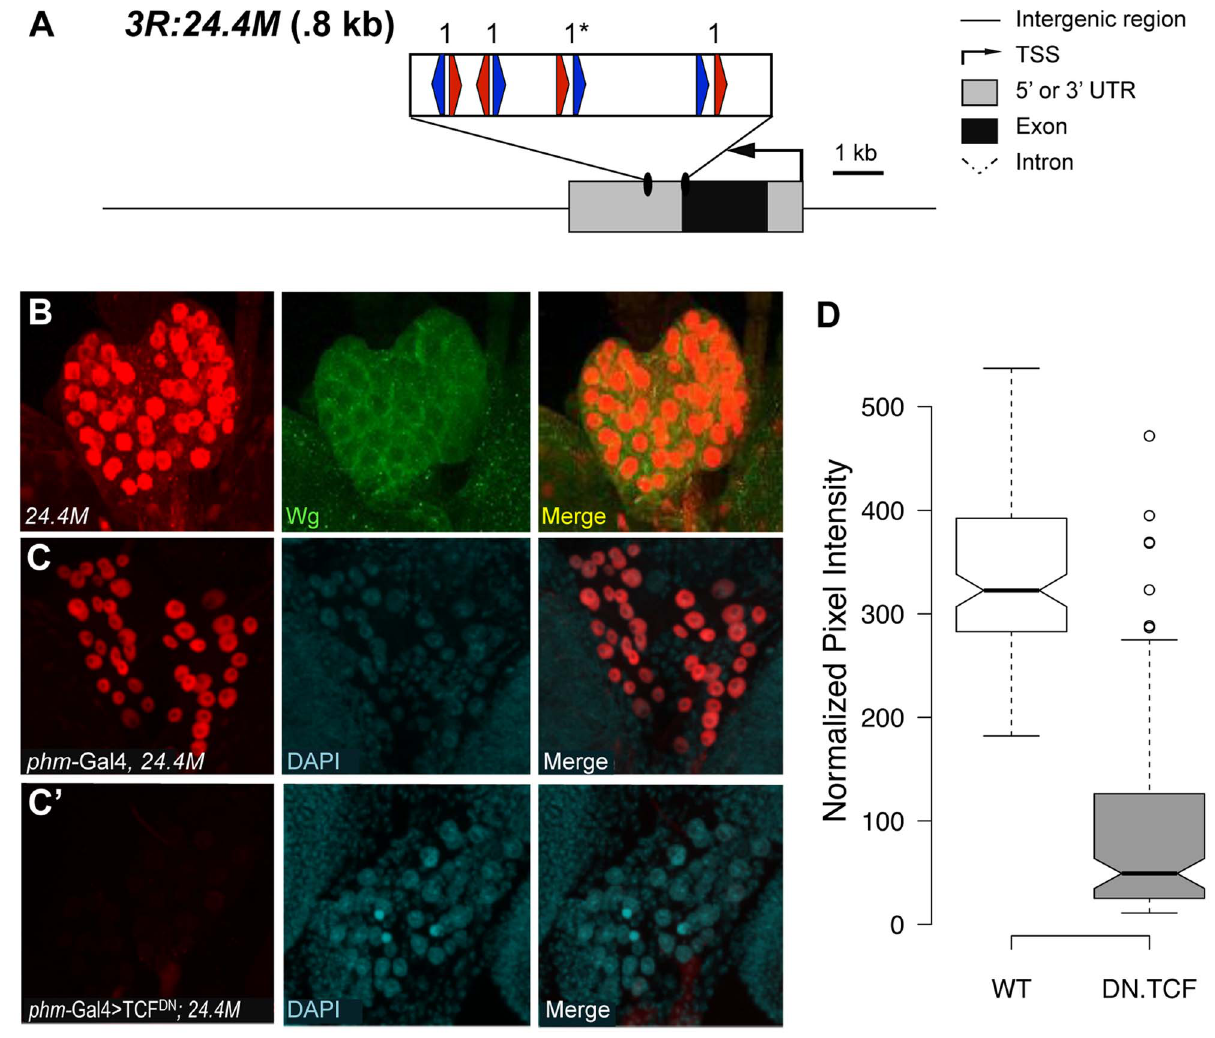
Figure 9. Identification of a W-CRM at 3R:24.4M that is active in the ring gland. (A) Cartoon of the W-CRM in relation to the fkh gene, with the location of HMG (red arrows) and Helper (blue arrows) sites indicated, along with their spacing. Asterisks indicate the high scoring FF1 motif identified in the initial computational search. (B) Confocal images of a 3 rd instar larval ring gland from a 3R:24.4M fly immunostained for lacZ and Wg. The large lateral cells of the prothoracic gland (PG) display strong nuclear LacZ staining. Wg protein can be seen at the cortical surface of these cells. (C, C 9 ) Confocal images of ring glands from phm Gal4 (C) or Phm Gal4 . TCF DN (C 9 ) ring glands containing the 3R:24.4M transgene immunostained for lacZ and DAPI. TCF DN expression results in a dramatic reduction in lacZ expression in The PG. (D) Normalized pixel intensity of the LacZ reporter was calculated for 120 nuclei representing each condition, and the data were summarized using a Tukey box plot, with outliers represented by circles.